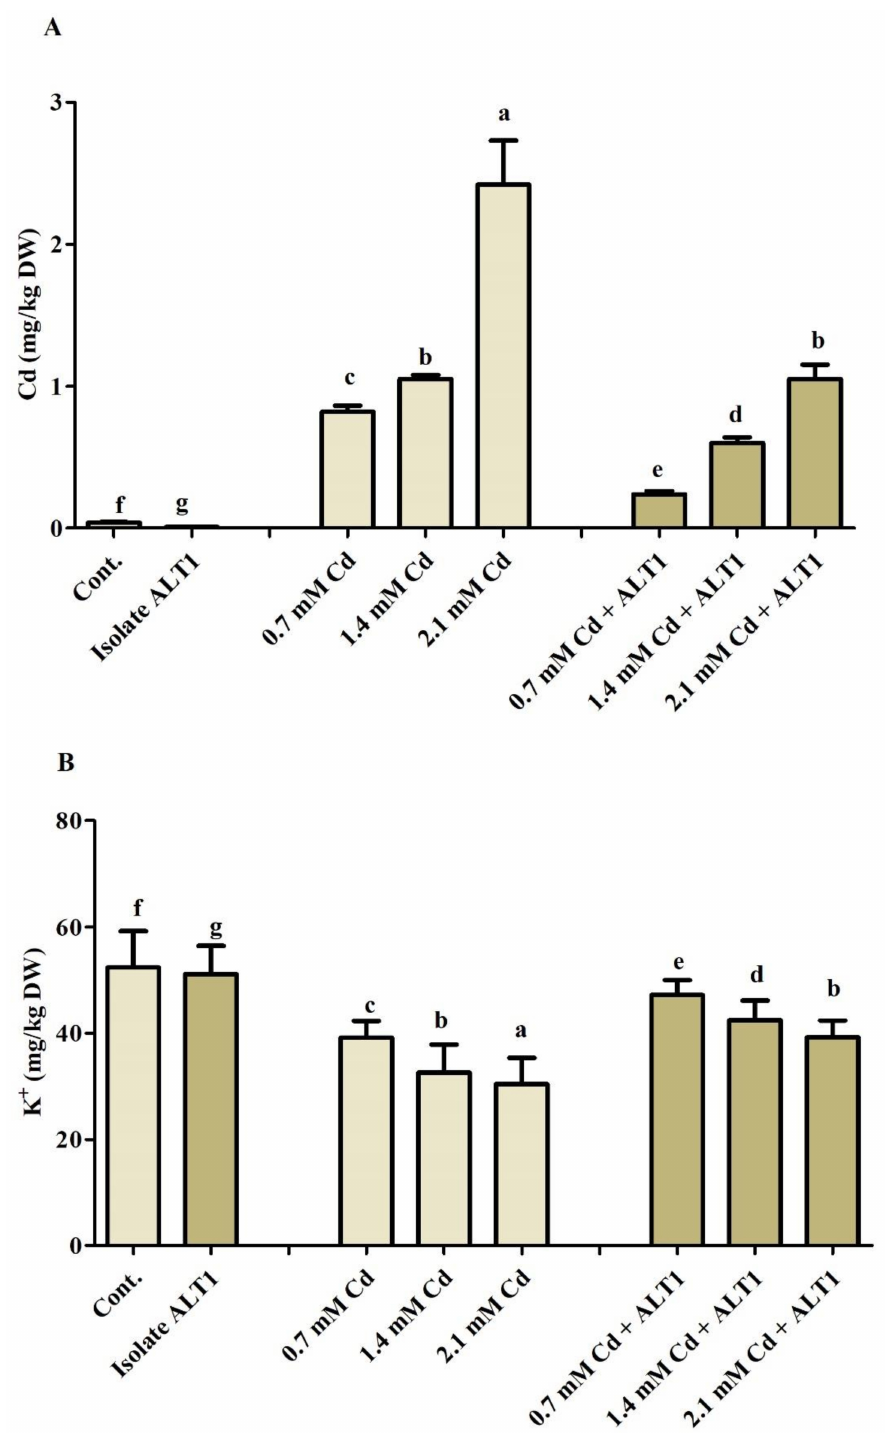
Figure 6. Effect of Cd stress on Cd and K uptake by ALT1-inoculated and non-inoculated soybean. ( A ): Cd (cadmium) content; ( B ): K + (potassium) content in soybean plants grown under normal and cadmium stress conditions. Each data point is the mean of three replicates. Error bars represent standard errors. The bars presented with different letters are significantly different from each other as evaluated by Duncan’s multiple range